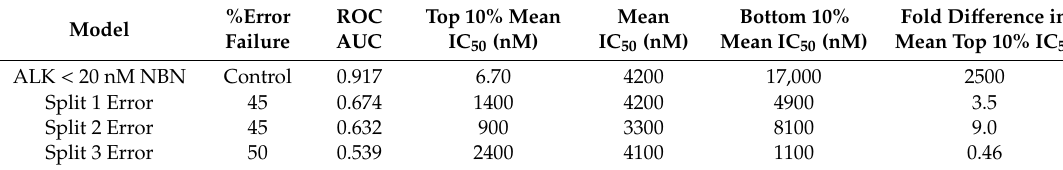
Table 3. Performance statistics for failed NBNs generated with the specified error in each split.